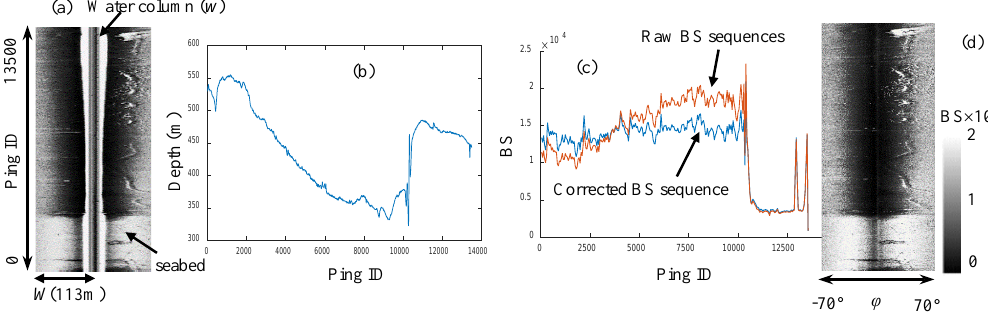
Figure 5. Bottom tracking and correction of along-track TVG residuals: ( a ) raw waterfall image; ( b ) sonar altitudes tracked along the survey line; ( c ) raw and corrected BS sequences with an incidence angle of 40°; and ( d ) waterfall image after the removal of the water column and correction ( φ denotes the incident angle).